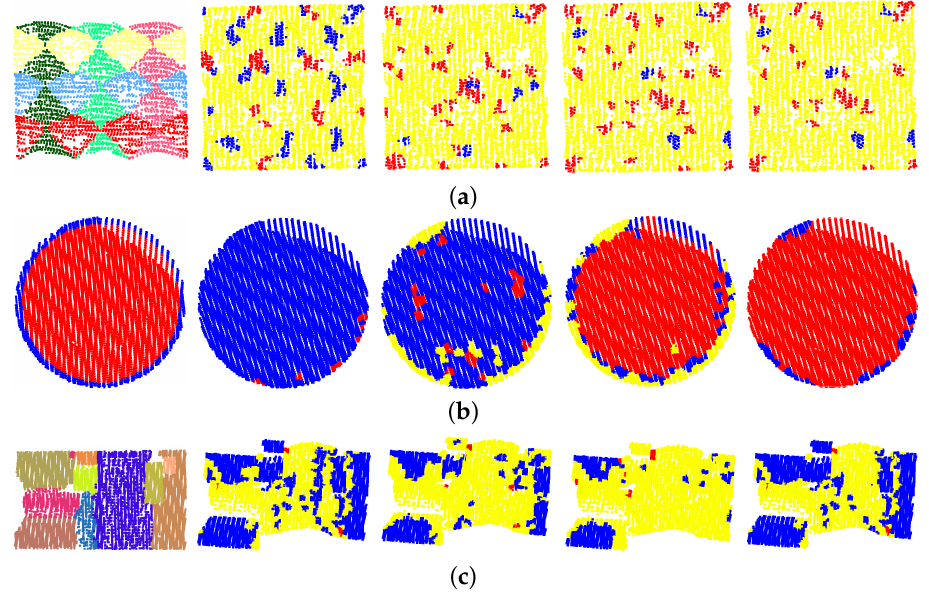
Figure 8. Comparison of the shape prediction results achieved under different searching scales. ( a , b ) are the areas marked as Figure 7e,c. ( c ) is the enlarged area marked as ‘2’ in Figure 6. From left to right: referenced segmentation result; prediction results of fixed neighborhood size: 10, 20, and 30; and our adaptive results. Red: sphere; yellow: cylinder; and blue: planar